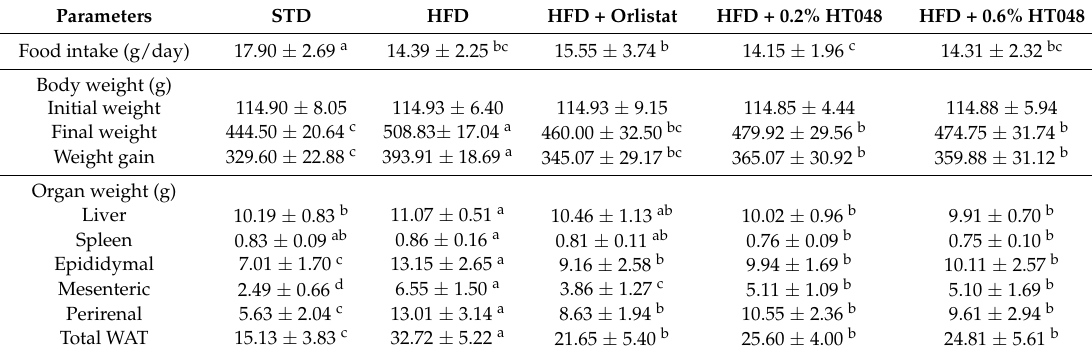
Table 1. Food intake, body weight, and organ weights.